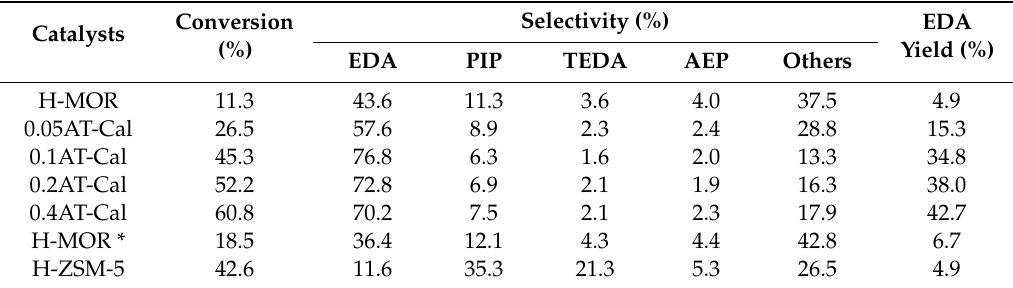
Table 3. Catalytic performances of the samples before and after alkali